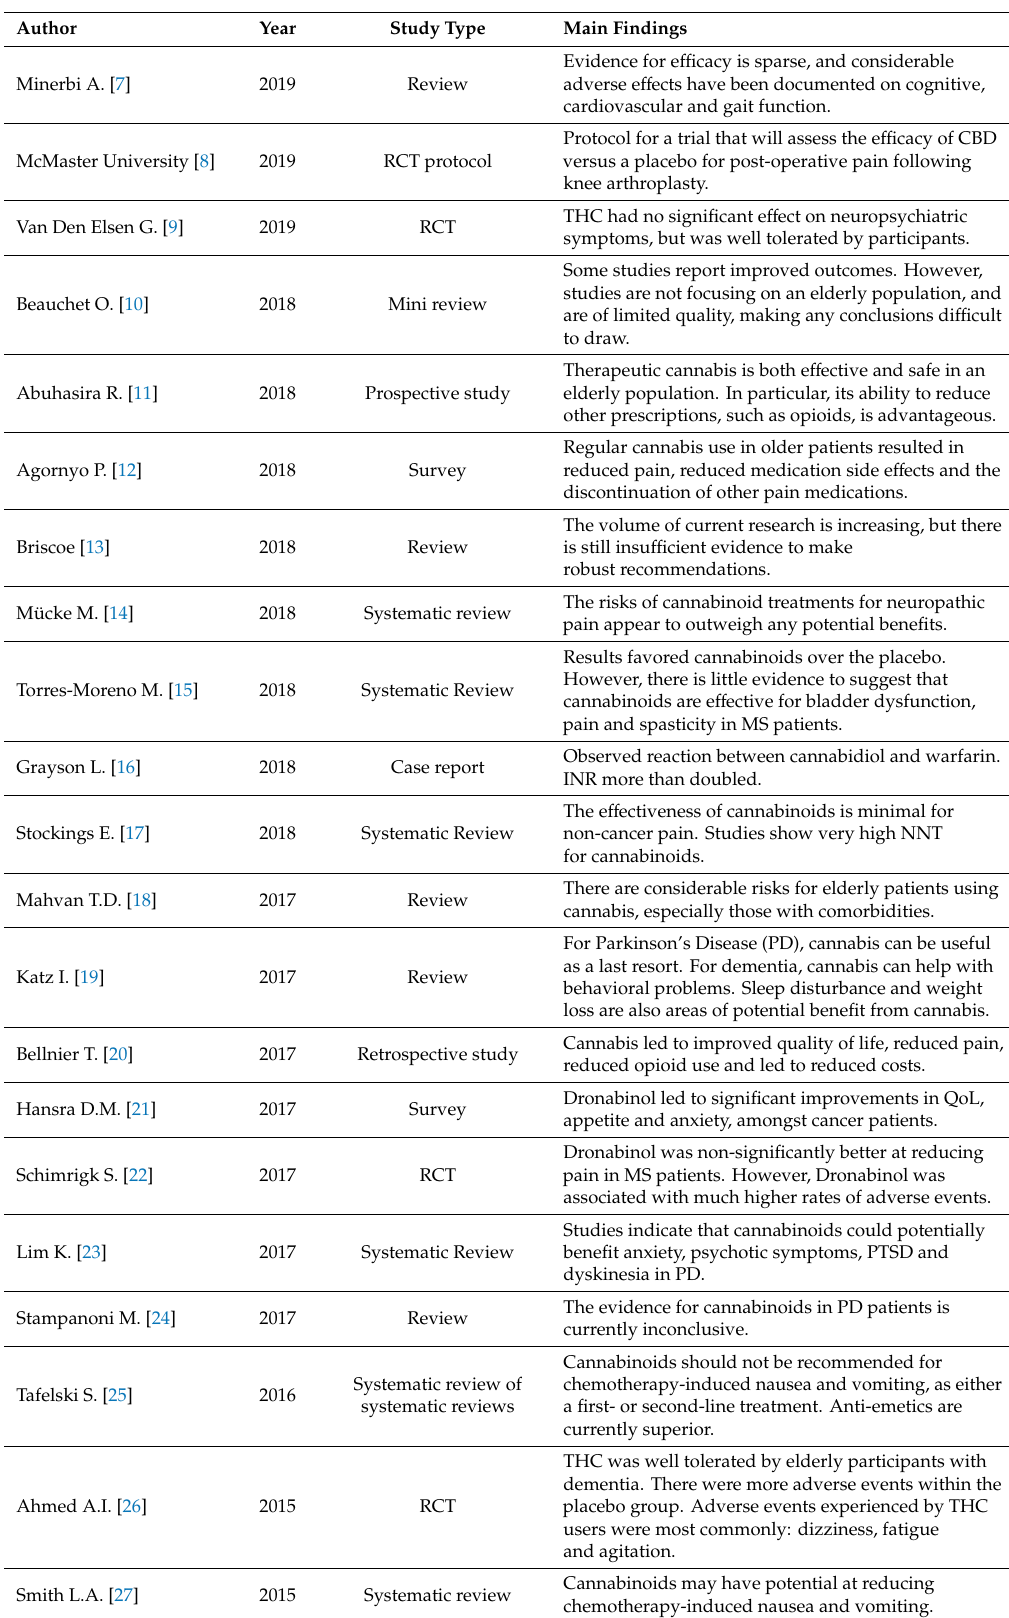
Table 1. Search results main